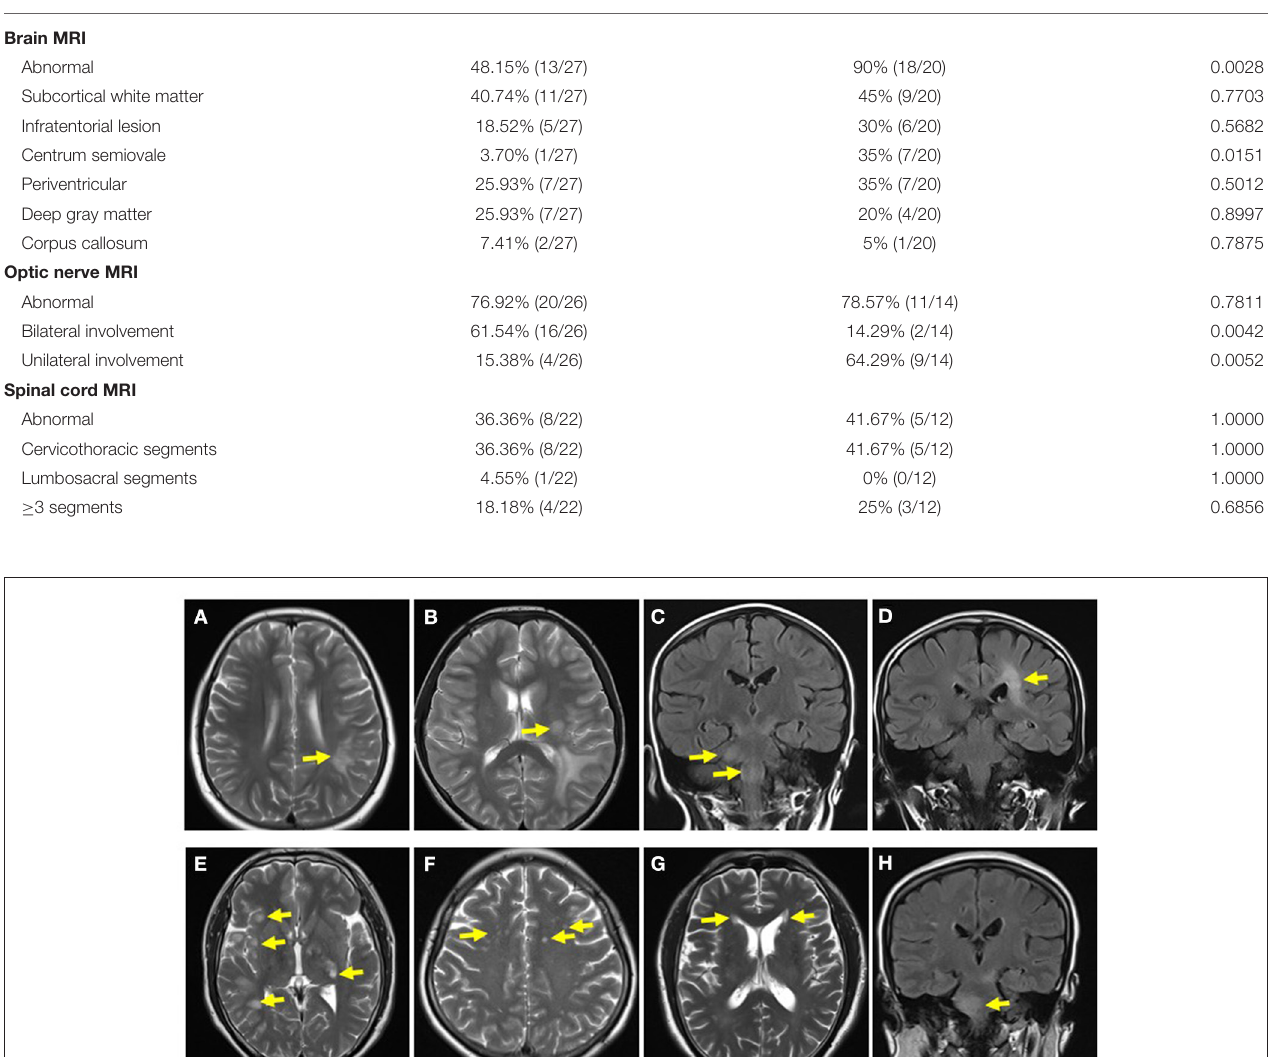
TABLE 3 | Comparison of the MRI manifestations of the pediatric and adult patients with MOG-EM. Pediatric group Adult group P -valve